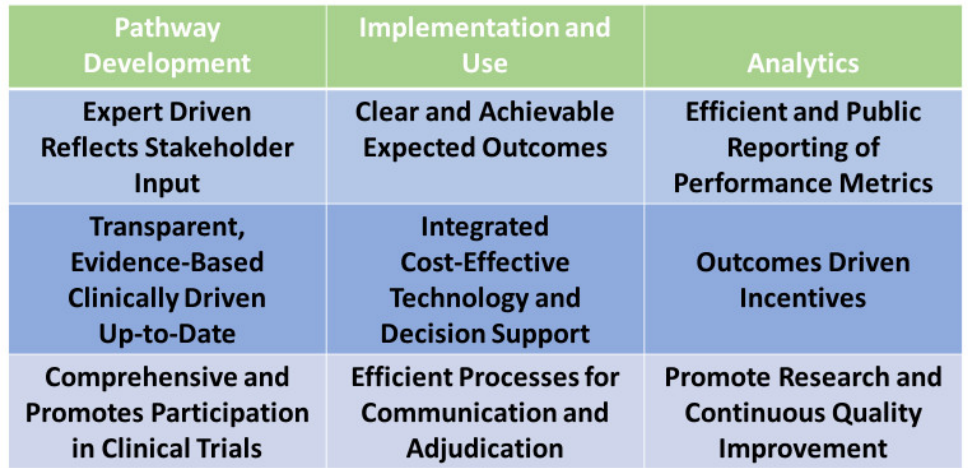
Figure 2. ASCO’s criteria for high-quality oncology pathway programs under pathway development, implementation and use, and analytics as described by Zon et al., J Oncol Prac 13:207–210, 2017 [63].